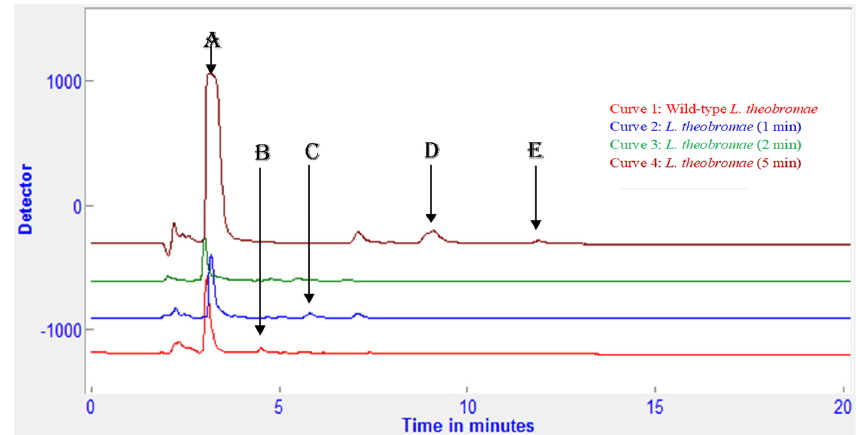
Figure 1. HPLC Chromatogram overlay of the wild type L. theobromae and UV-treated L. theobromae